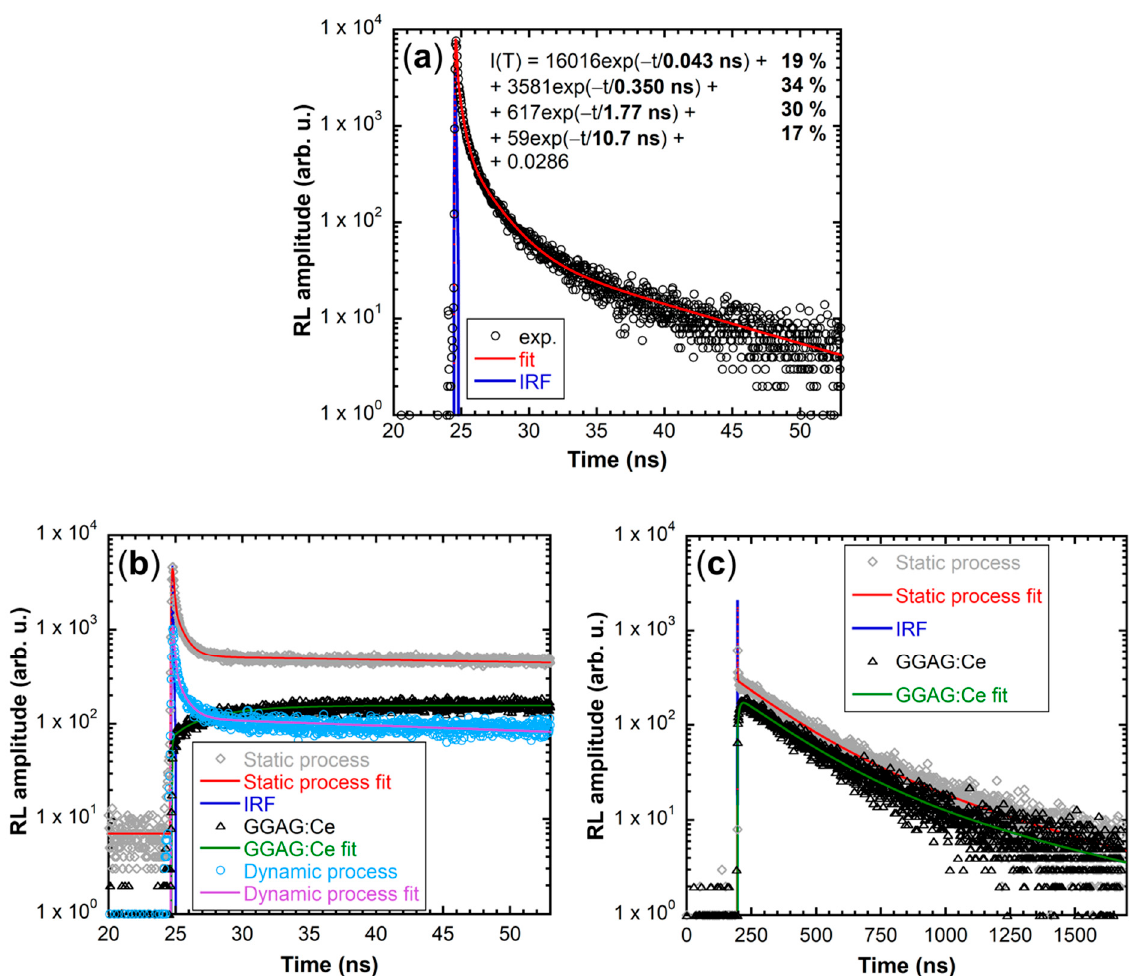
Figure 6. ( a ) Scintillation decay of the pure CsPbBr 3 film prepared by the static process (50 layers) on glass. ( b ) Scintillation decays in the short time window of CsPbBr 3 films on GGAG:Ce prepared by the static process (grey diamonds, red line) and the dynamic process (light blue circles, purple line) compared to the scintillation decay of pure GGAG:Ce wafer (black triangles, green line). ( c ) Scintillation decays in the long time window of the CsPbBr 3 film on GGAG:Ce prepared by the static method (grey diamonds, red line) compared to the scintillation decay of the pure GGAG:Ce (black triangles, green line). Blue line represents the instrumental response function (IRF) in all graphs.